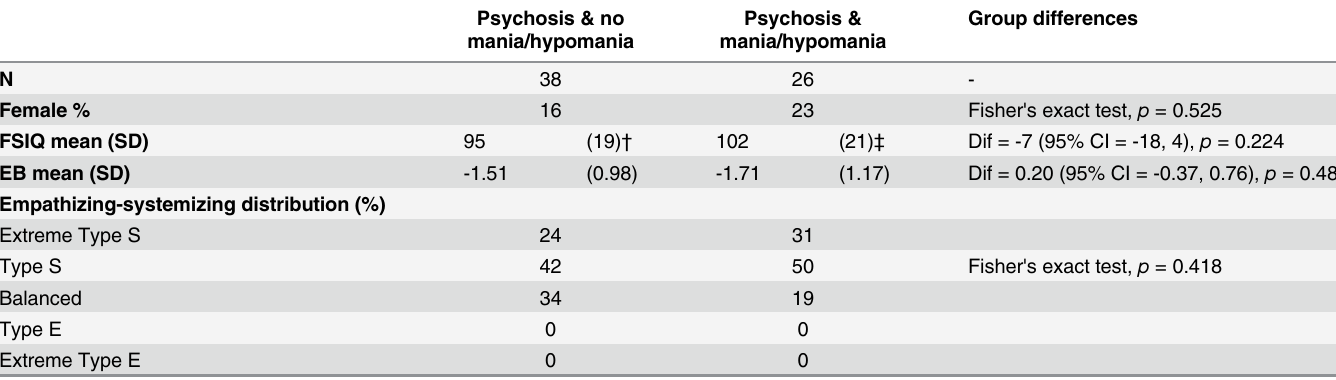
Table 3. Raw differences between those with and without mania/hypomania, within the psychotic group.